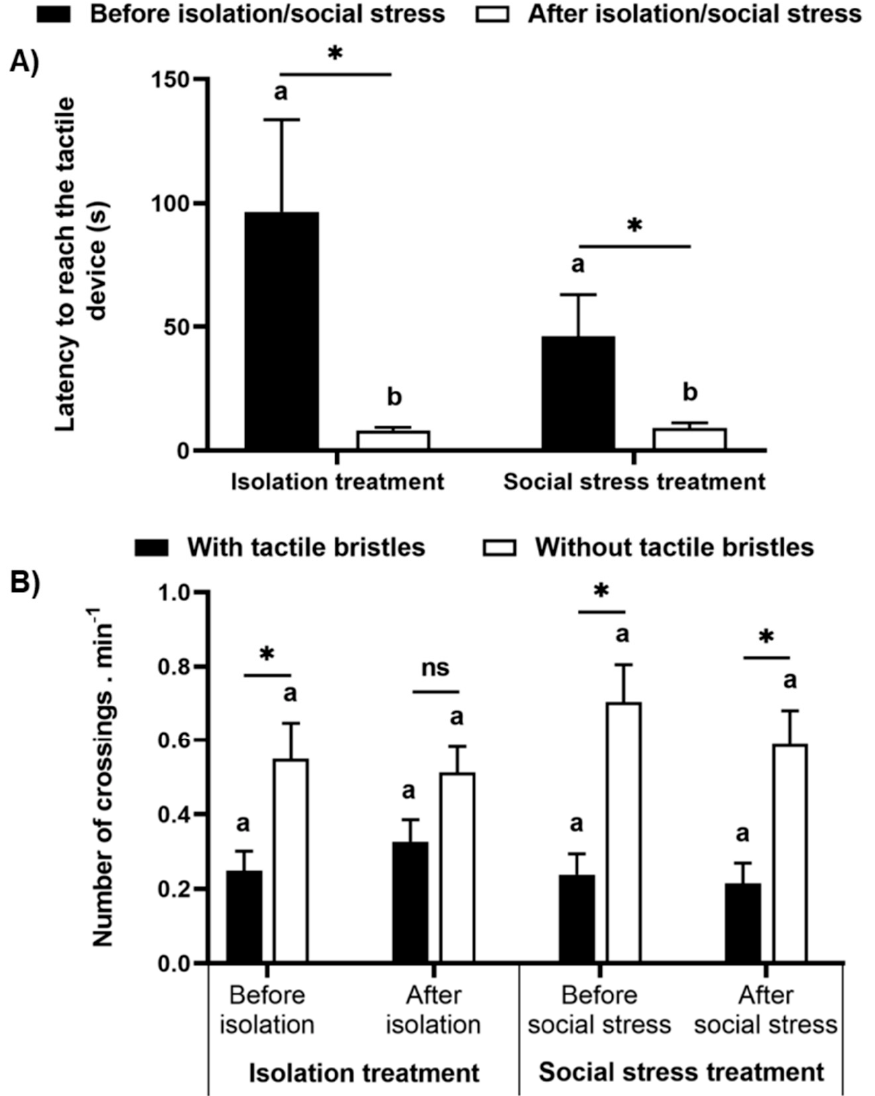
Figure 6. Motivation test. ( A ) Latency to access the tactile device and ( B ) the number of crossings per minute through the areas with and without tactile bristles after the fish leave the refuge, in both periods, before and after manipulation (isolation or aggressive interaction). Data are mean ± SE. Mixed model ANOVA followed by SNK post hoc test. The asterisk indicates significant differences between ( A ) periods before and after manipulation within treatments and ( B ) the areas with and without tactile bristles within treatments in the periods. Letters compare periods before and after manipulation ( A ) between treatments and ( B ) for control and treatment groups. Similar letters indicate no significant